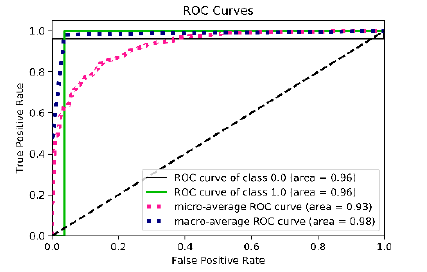
Figure 16. ROC curves of landslide susceptibility map